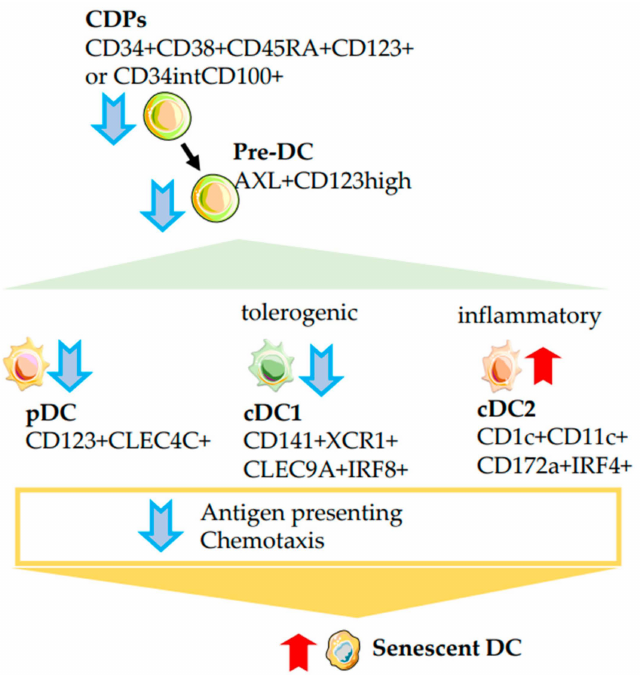
Figure 4. Ageing of dendritic cells. The decrease in the number of common dendritic cell progenitors (CDPs) and immediate dendritic cell precursors (pre-DCs) affects the development of the entire DC hierarchy. The age-related decrease in the number of DC precursors reduces the total number of DCs, as a result, antigen presentation, migration to inflammation foci and lymphoid organs become insufficient. The balance between tolerogenic and inflammatory DCs changes with age. Plasmacytoid pDCs, tolerogenic conventional DC1s (cDC1s), decrease in number, while inflammatory DC2s increase. The rise in DC populations with age is shown by the red arrow pointing up, and the decline is shown by the blue arrow pointing down. A gradual accumulation of aging DCs is